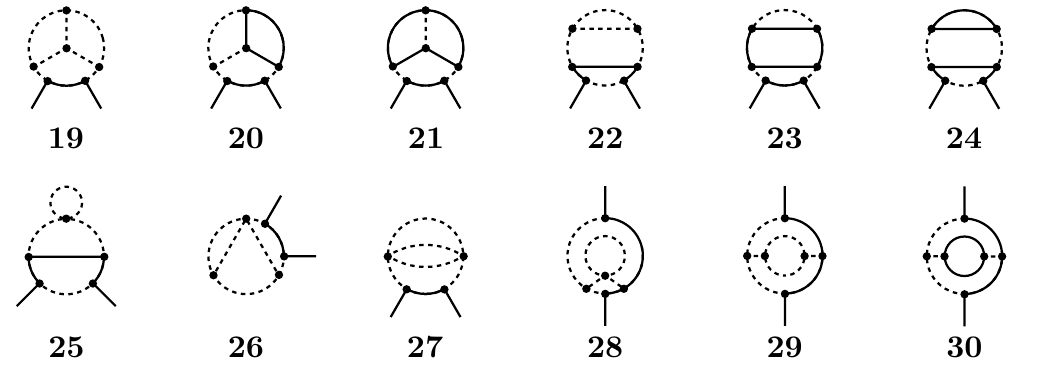
Figure 8 . List of special genuine diagrams, with the external Higgs lines removed. Diagrams in this list are referred to in the text as D M , where i is the number of the diagram shown i